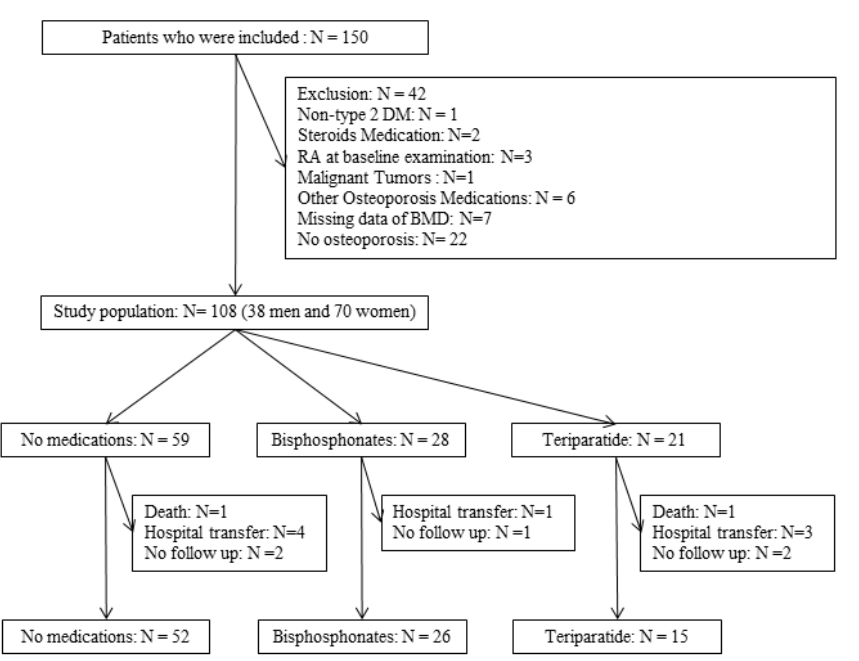
Figure 1. Inclusion and exclusion flow.